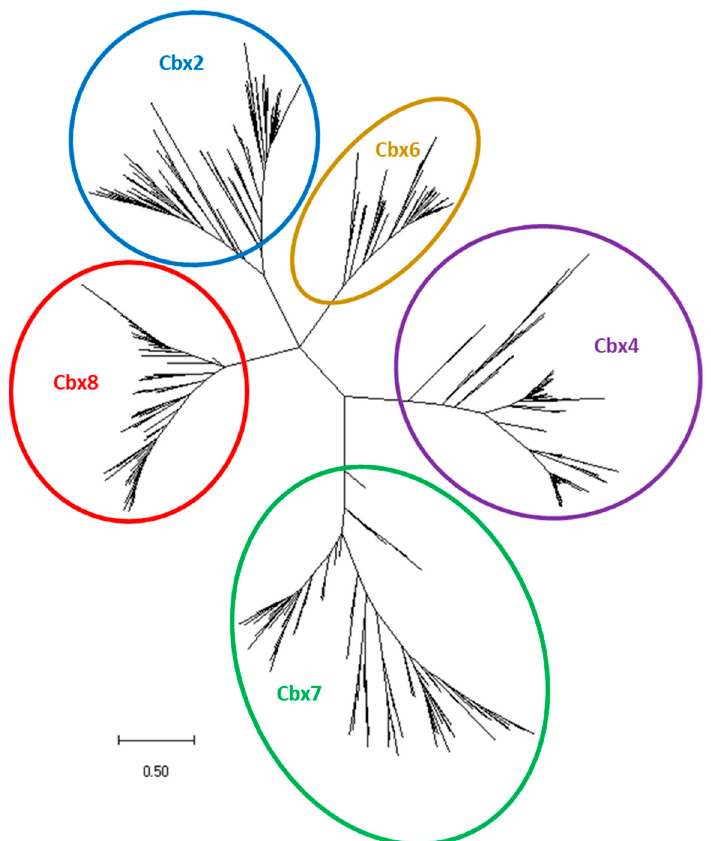
Table S1). In contrast to Psc / PCGF and Sce / RING1 orthologues that are not all present in fishes including zebrafish and medaka [37], the five cbx paralogues, cbx2 , cbx4 , cbx6 , cbx7 and cbx8 , are maintained in all sequenced teleost genomes. In many cases, but not systematically, the cbx genes are even retained as pairs of ohnologues (Supplementary Table S1). Genes 2020 , 11 , x FOR PEER REVIEW